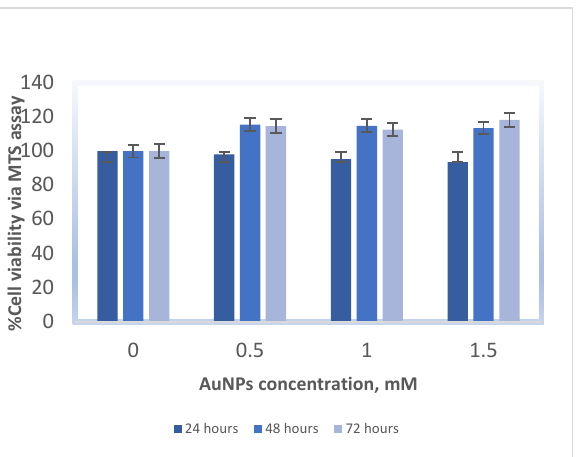
Figure 1. Illustration of cellular mitochondria exposed to ionising radiation in the presence of nano- particles that can amplify the pathway of ROS-induced cell death.